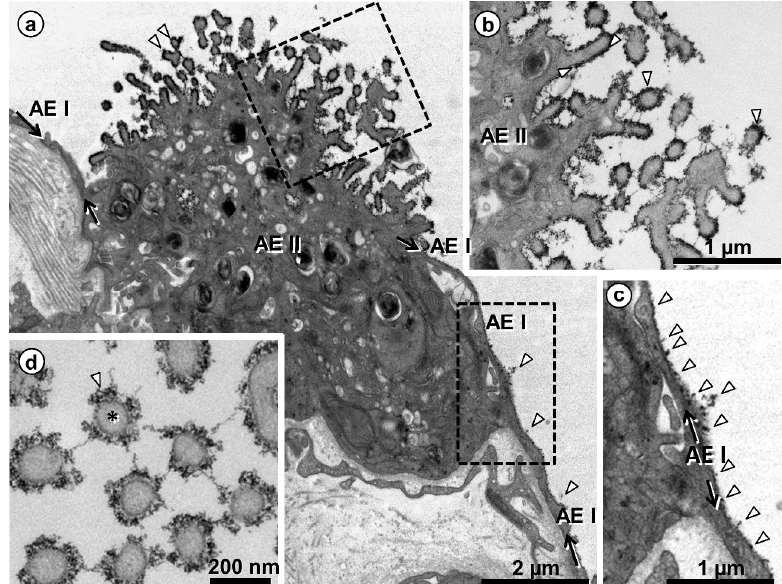
Figure 4. Human lung. Visualization of the glycocalyx on the surface of alveolar epithelial type I (AEI) and type II (AEII) cells. ( a ) Overview showing one AEII cell and neighboring thin AEI cell extensions, the lineage of the latter highlighted by arrows. The black lining and dots on the cell surfaces (arrowheads in ( a )) depict the glycocalyx, marked by colloidal thorium dioxide. The boxed areas are shown in ( b , c ) at higher magnification. Note heavily stained microvilli (arrowheads in ( b )) and staining at the apical cell membrane of AEI cell (arrowheads in ( c )). ( d ) Profiles of cross-sectioned microvilli (one of them marked by asterisk) of an AEII cell. The glycocalyx (arrowhead in ( d )) surrounds the microvilli and also appears as threads between them. Int. J. Mol. Sci. 2020 , 21 , x FOR PEER REVIEW